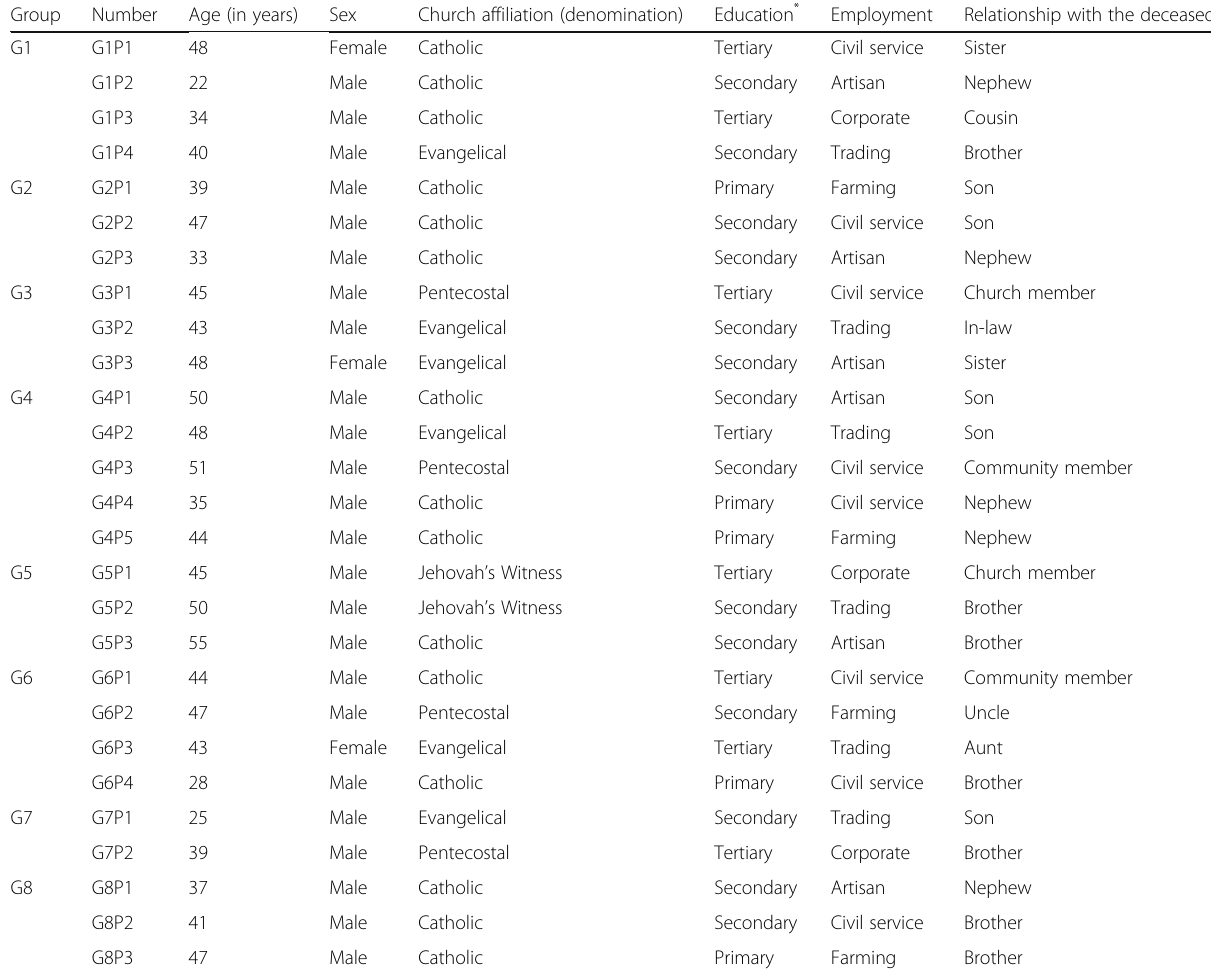
Table 1 Sociodemographic characteristics of participants Group